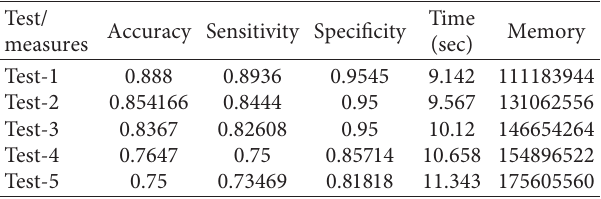
Table 1: Overall performance result of AONN. Test/